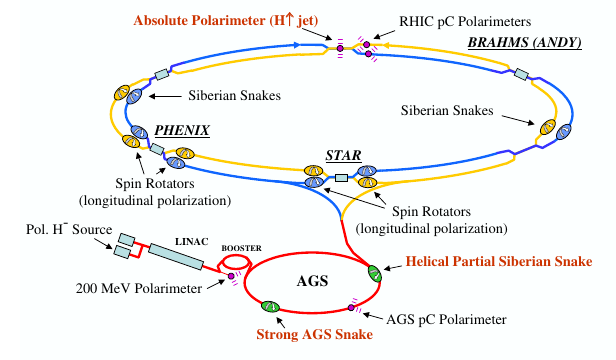
Figure 1. Schematic of RHIC as a polarized proton collider. Po- larization is produced at the source, and is preserved through the acceleration sequence using Siberian Snake magnets. Each ring has two full snakes that each precess the polarization by 180 ◦ . Beams are transversely polarized in the rings. Spin rotator mag- nets can precess the polarization to become longitudinal at STAR and PHENIX. The 2 o’clock interaction region was originally for the BRAHMS experiment, and later for the A N DY experiment. Results from both are discussed